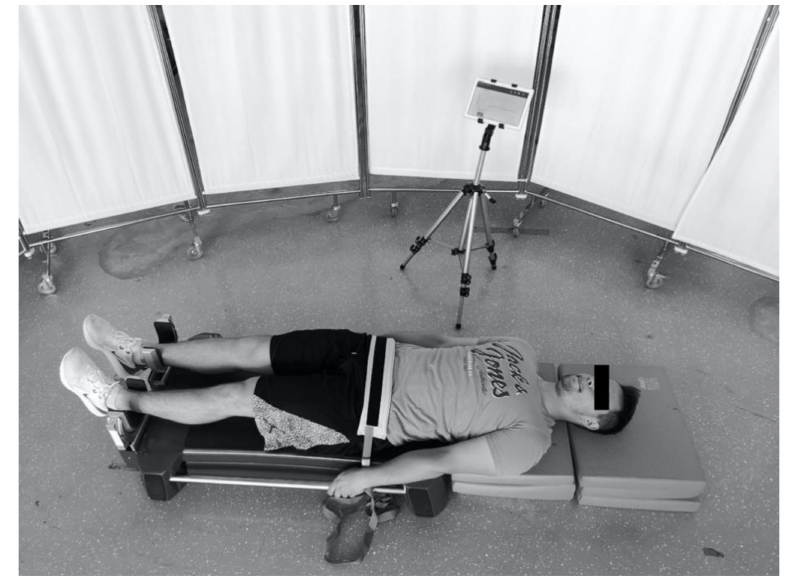
Figure 1. Position of the participant during isometric adductor strength